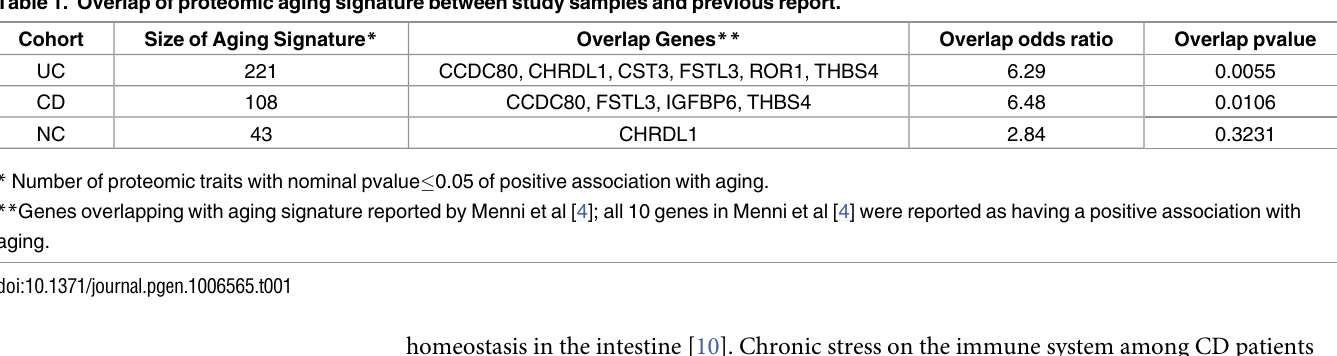
Table 1. Overlap of proteomic aging signature between study samples and previous report.